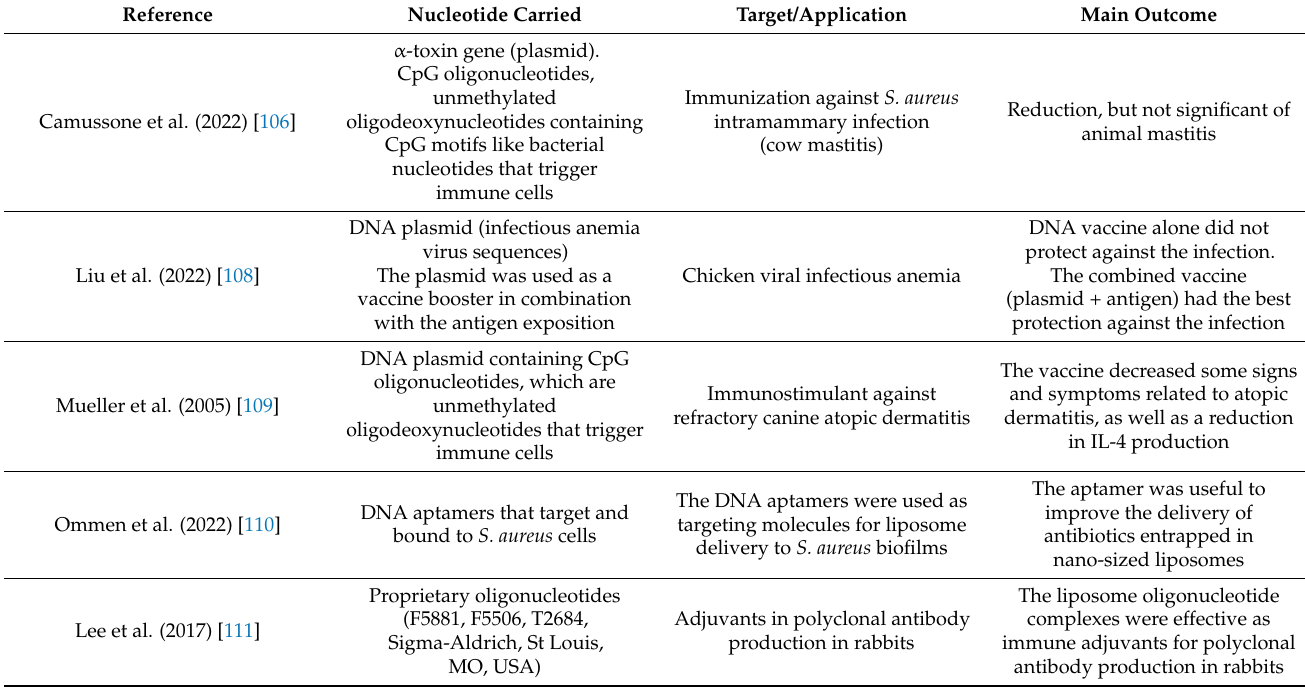
Table 4. Veterinary